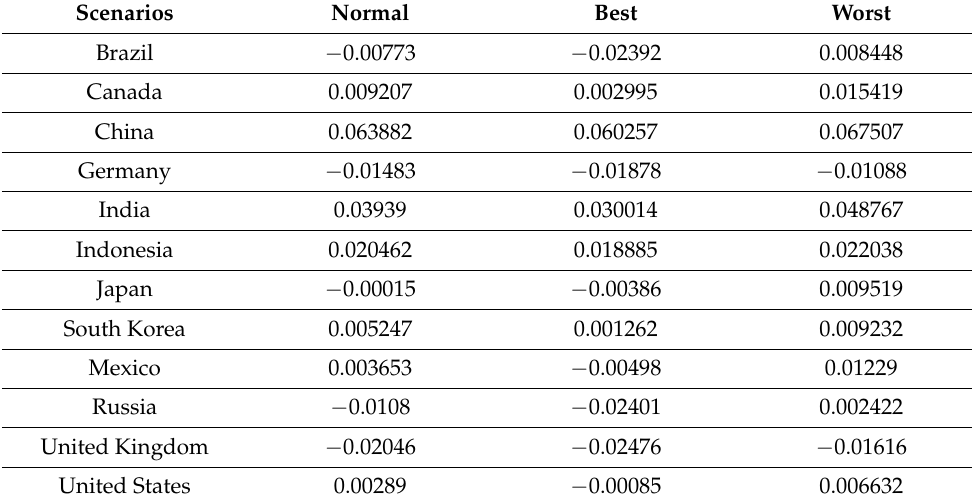
Table A2. Differences in the amount of CO 2 emissions in three